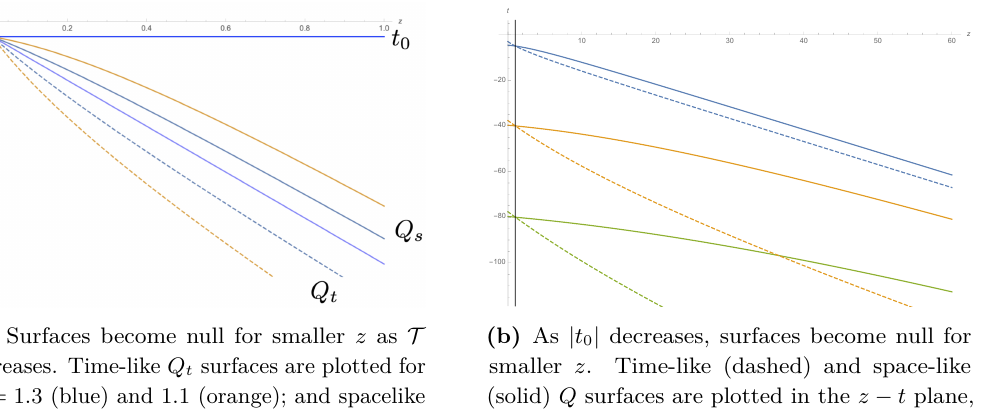
Figure 1. Time-like and space-like Q surfaces in the z − t plane (dashed and solid